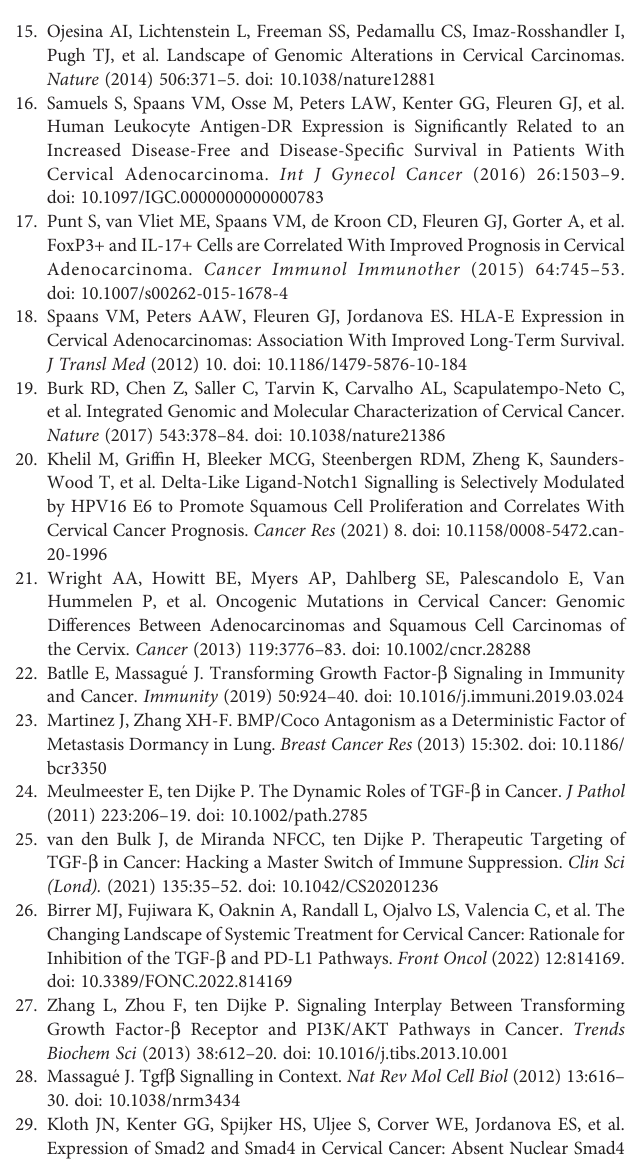
antibodies were described previously. Supplementary Table 2 | The 153-gene TGF- b response signature as de fi ned by Padua et al. (38). The gene names are indicated, as well as their up- or downregulated status in the original